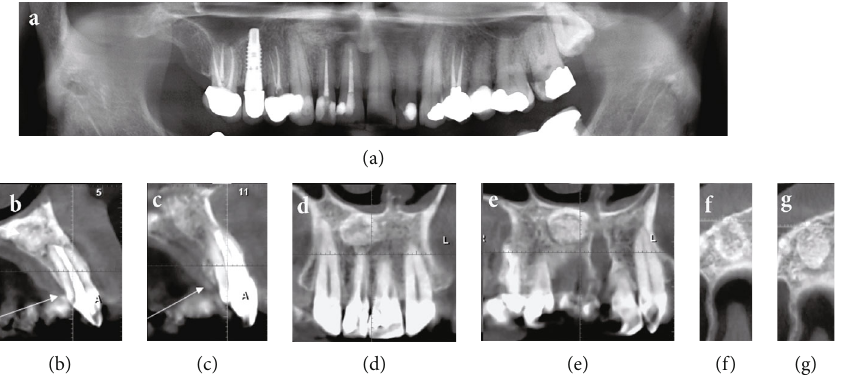
Figure 4: Two-year follow-up radiographic evaluation: (a) panoramic view: bone healing in the periapical areas of teeth #11 and #12; (b, c) axial views from teeth #11 and #12: bone augmentation in the palatal aspect of the maxilla; (d, e) frontal views of maxillary anterior teeth: there is no sign of radiolucent lesion around teeth #11 and #12 and bone substitute material can be observed; (f, g) transverse views of the area: successful bone